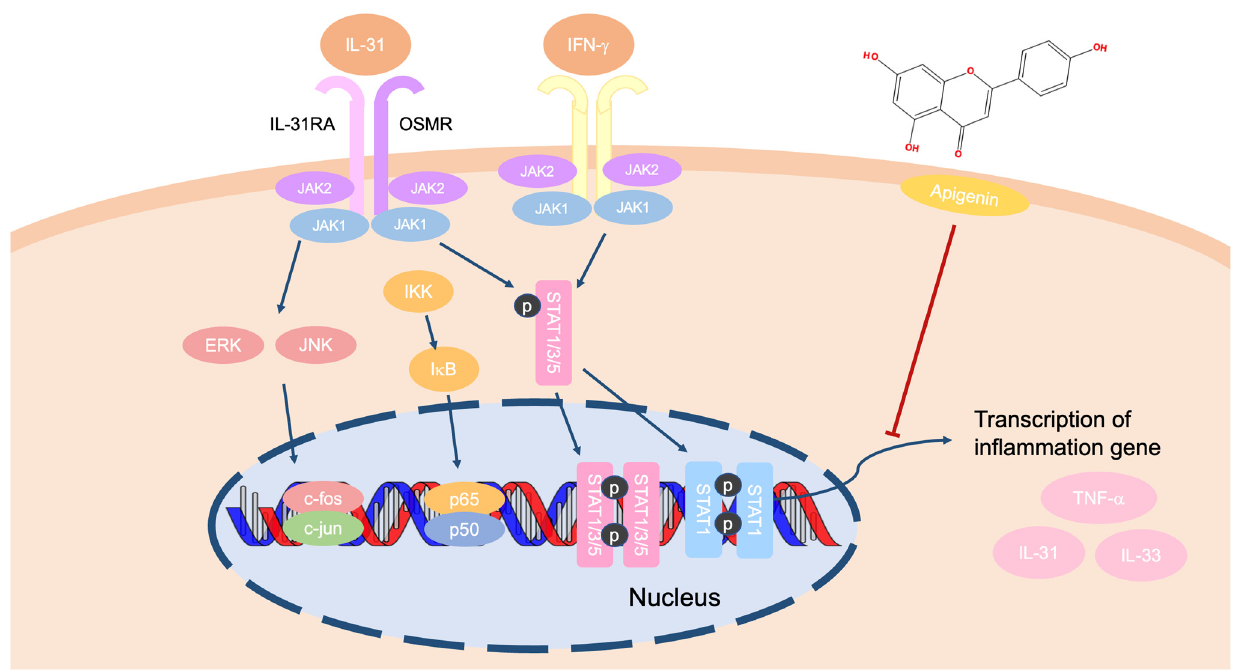
Figure 5. A schema of the efficacy of apigenin against pruritus.